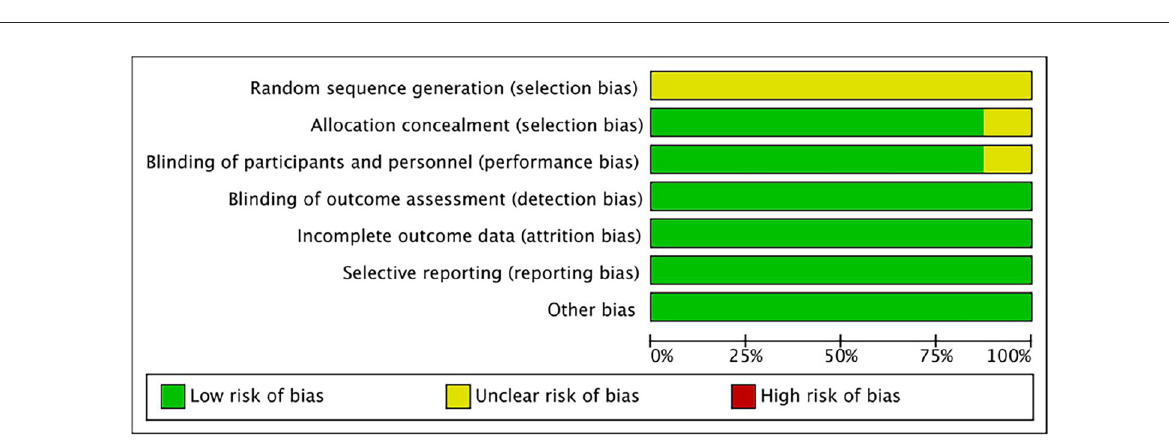
FIGURE3 Risk of bias graph authors’ judgments about each risk of bias item, presented as a percentage across all induded